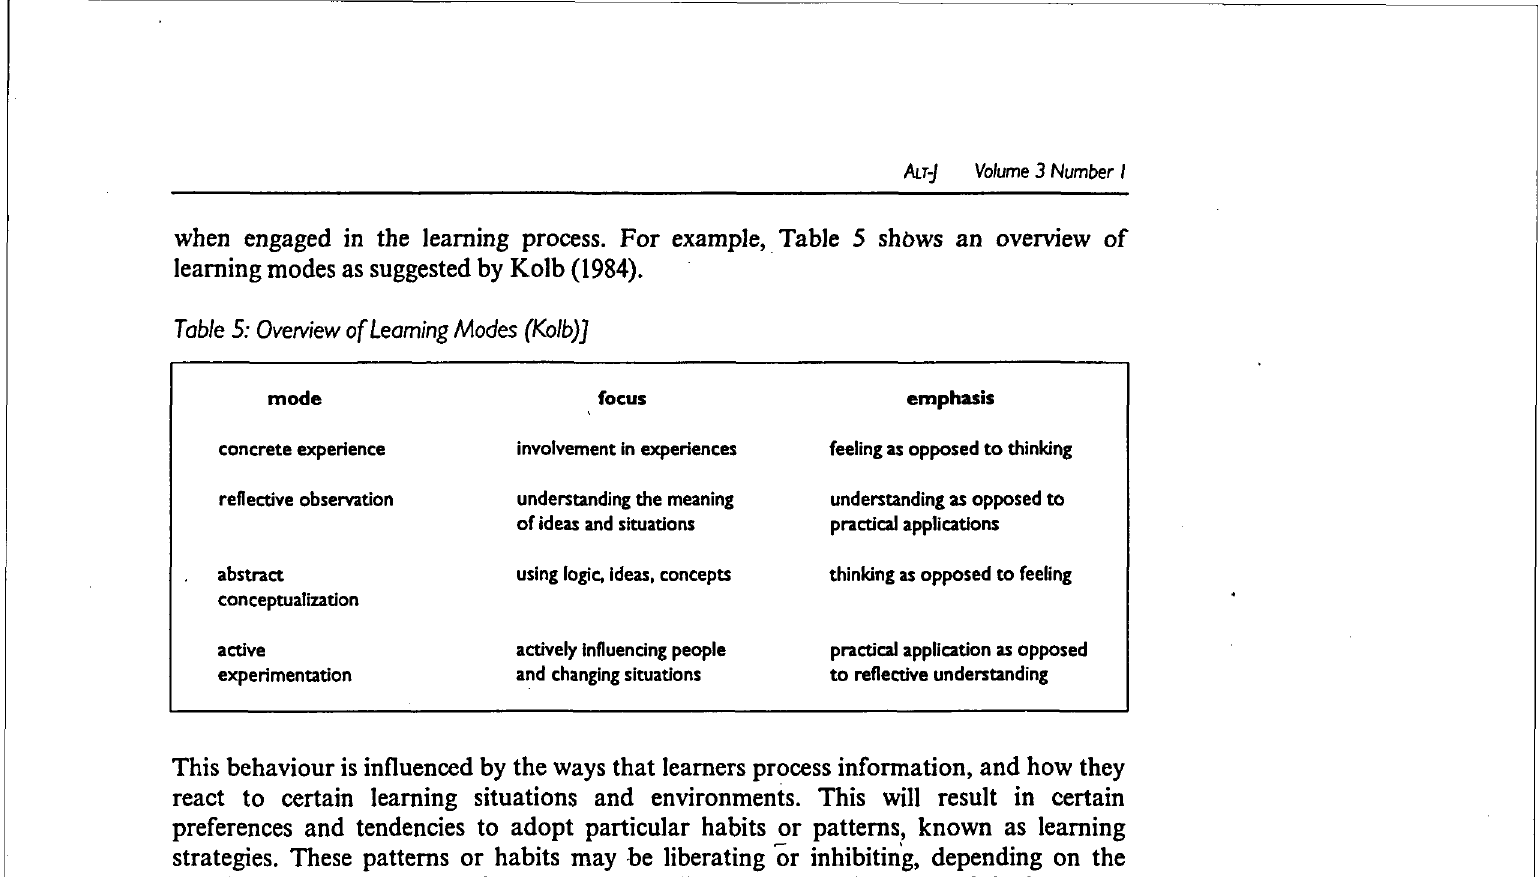
Table 5: Overview of Learning Modes